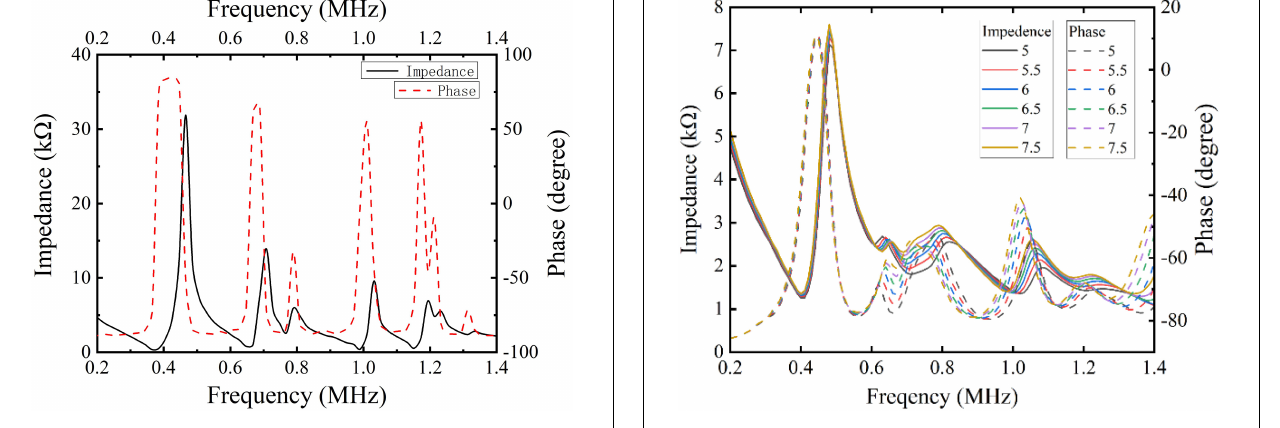
FIGURE 2 | Electrical impedance and phase plots of pic255. FIGURE 3 | The impedances of different curvatures of piezoelectric